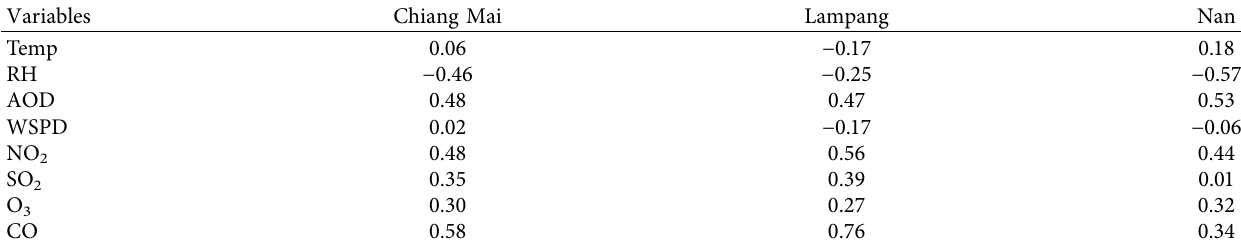
Table 3: Pearson correlation between PM